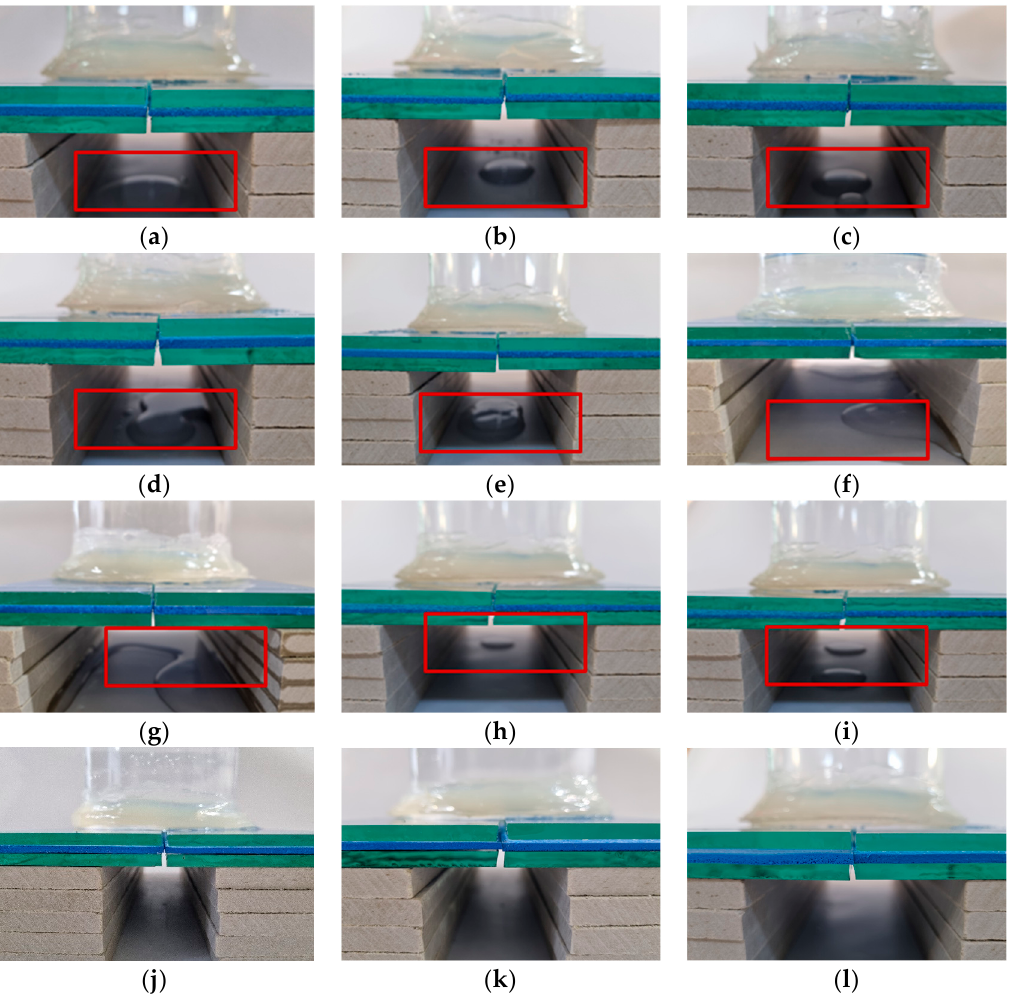
Figure 10. The waterproofing performance evaluation results of water-expandable polyurethane